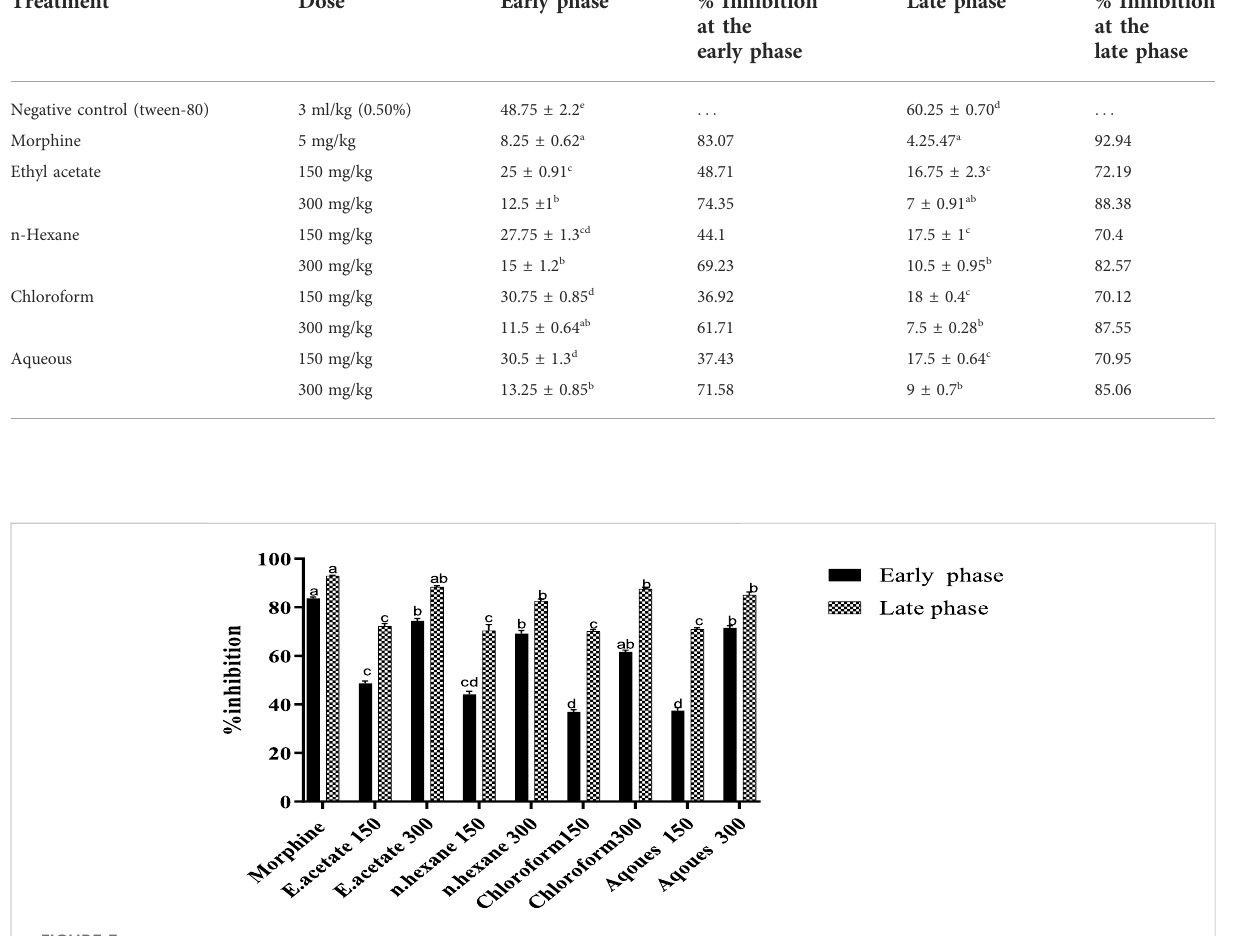
FIGURE 3 Effect of various fractions of Justicia adhatoda at doses of 150 and 300 mg/kg in the formalin-induced licking paw test in Swiss albino